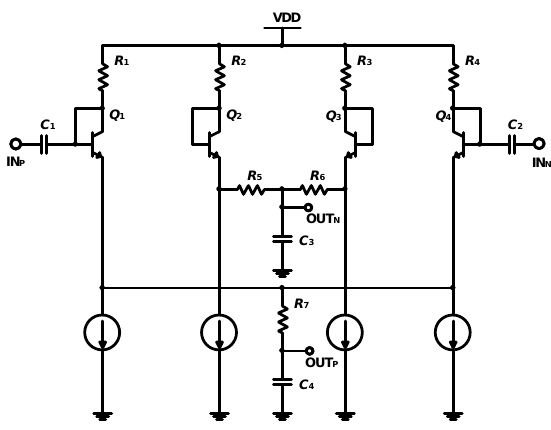
Figure 11. Schematic diagram of the detection circuit.